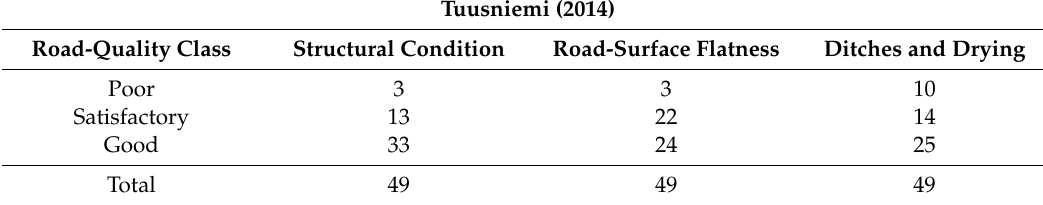
Table 1. Distribution of field plots in the Tuusniemi area into road-quality classes based on a field inventory following the Finnish forest road-quality standards [24]. The categories are explained in more detail above; ( n =